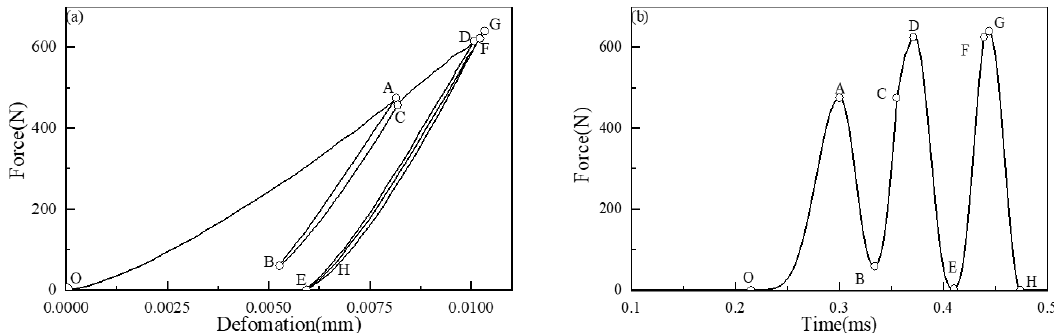
Figure 7. Multiple loading and unloading behaviors in Case 3 ( λ = 1): ( a ) Contact force-deformation curve of the contact pair between granule 10 and granule 11; ( b ) Contact force-time curve of the contact pair between granule 10 and granule 11.